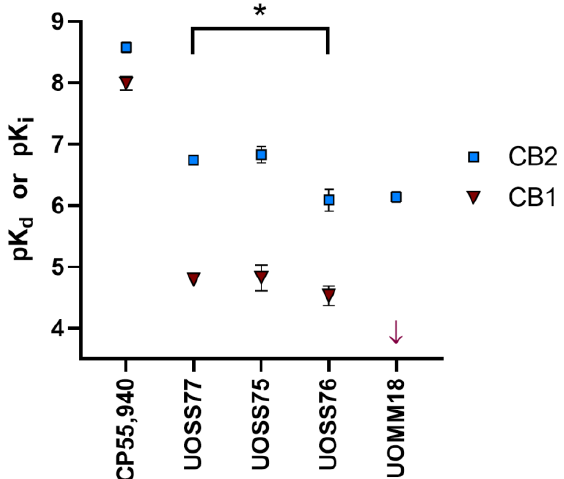
Figure 1. Binding affinities of compounds of interest at human CB2 or CB1 determined from radioligand competition binding assays (pK d for CP55,940, pK i for other compounds). Data are mean ± SEM from three to four independent experiments, except for UOSS75 at CB1 ( n = 2). CB1 pK i values for all compounds, other than CP55,940, are estimates (see main text and Table 1). The arrow for UOMM18 in the CB1 set indicates no detectable binding to the lowest possible affinity constant measurable in our assay (pK i < 4). CB2 affinity was statistically compared between UOSS77 and its novel derivatives; * represents p < 0.05.